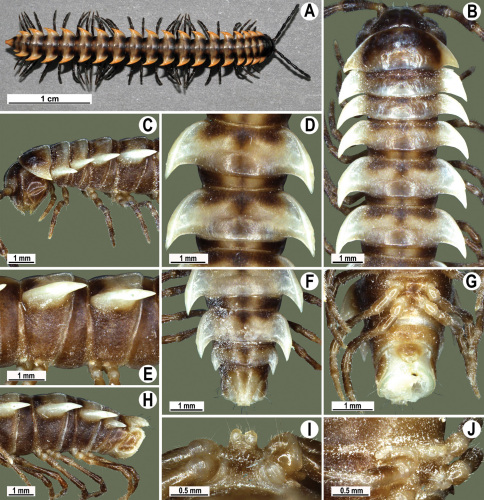
Orthomorpha pterygota Golovatch, 1998, ♂ from Kathu Waterfall (A), ♂ from Panwa Cape (B-J). A habitus, live coloration B, C anterior part of body, dorsal and lateral views, respectively D, E segments 10 and 11, dorsal and lateral views, respectively F, G, H posterior part of body, dorsal, ventral and lateral views, respectively I, J sternal cones between coxae 4, subcaudal and sublateral views, respectively.